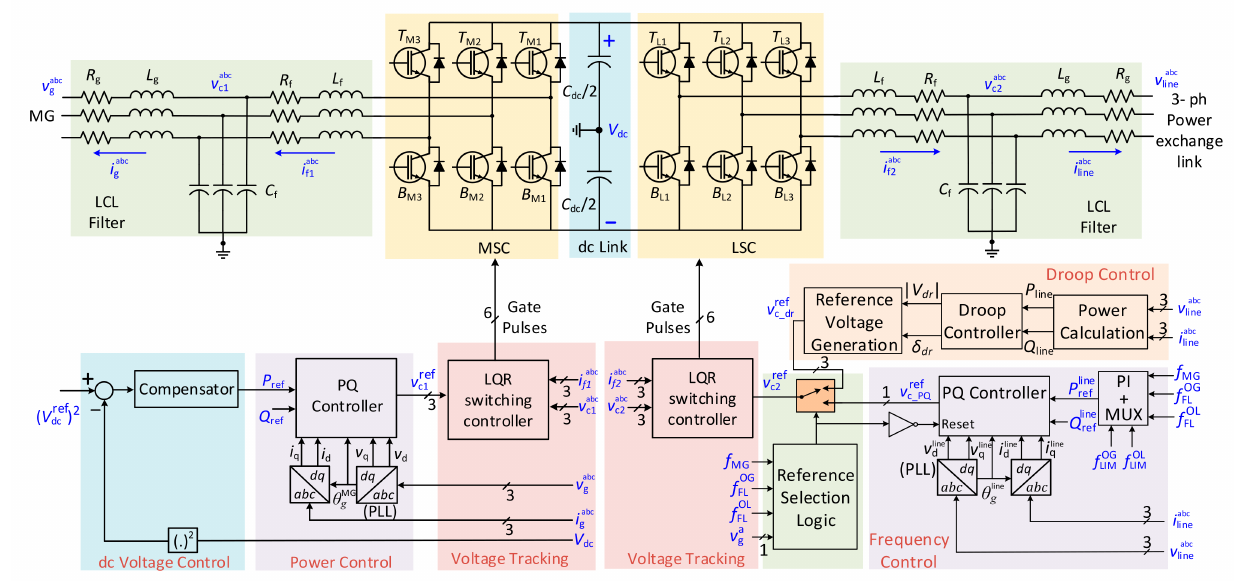
Figure 2. Assumed structure for MSC and LSC connection topology with power exchange lines and their closed-loop